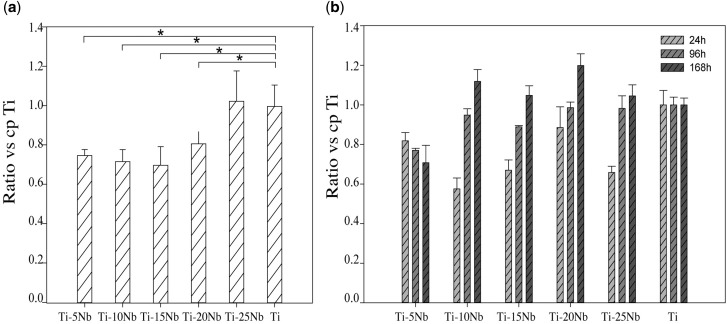
(a) Concentration of LDH at 24 h and (b) proliferation assay of MC3T3-E1 at 24, 96 and 128 h. The result was expressed as the ratio versus cp-Ti (%)